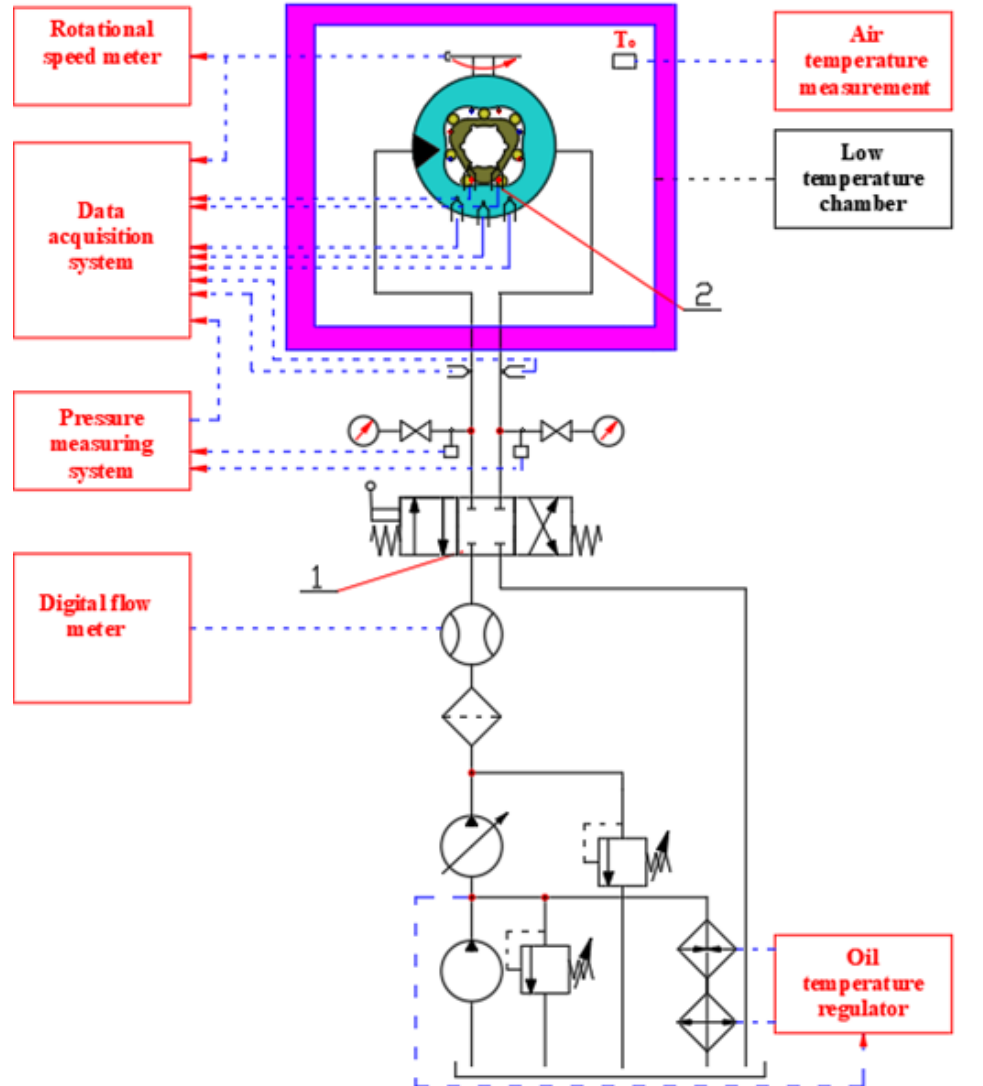
Figure 10. Schematic drawing of the hydraulic system with satellite motor (1—spool valve, 2—tem- perature sensors located in the movable and fixed parts of the motor). 2—temperature sensors located in the movable and fixed parts of the